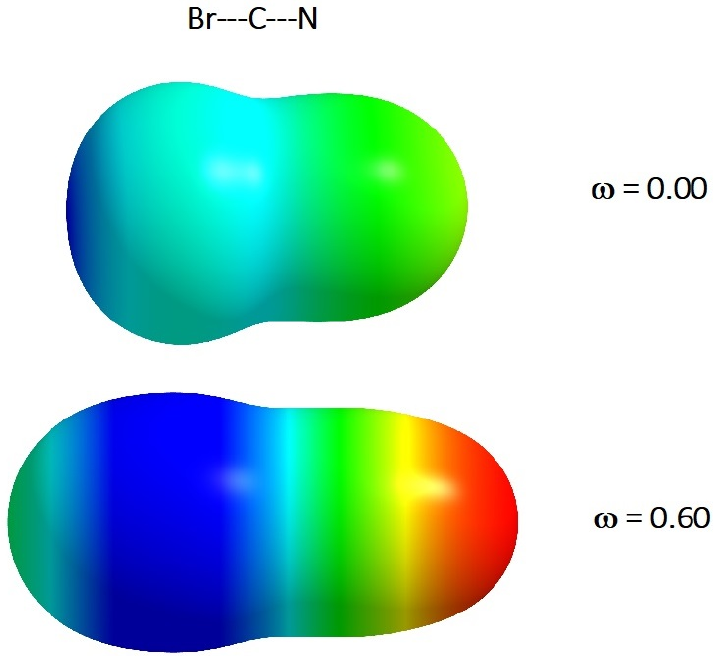
Figure 2. The ω B97X/aug-cc-pVTZ calculated MEP on the 0.001 a.u. isodensity surface of BrCN molecule (for the free molecule as well as for the molecule upon confinement). The meaning of the colors is explained in the text.